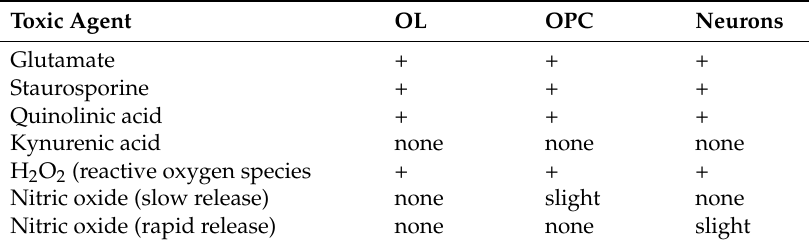
Table 1. ACTH Protects Oligodendroglia, Oligodendroglial Progenitors and Neurons from Multiple Toxic